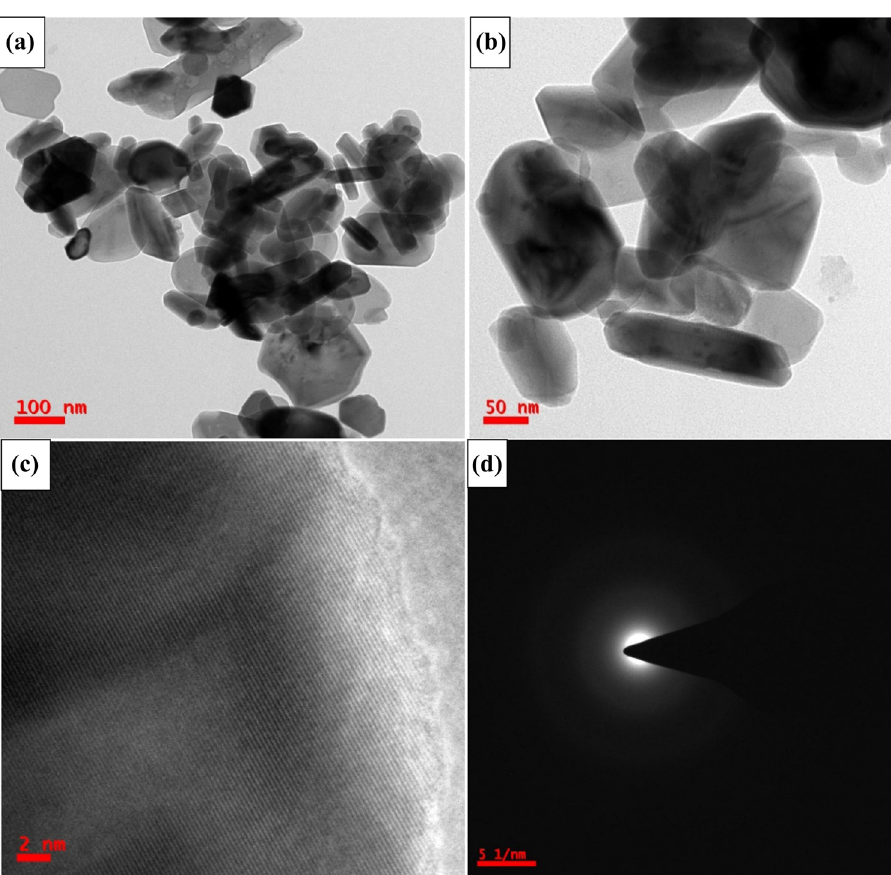
Figure 21: ( a ) and ( b ) TEM images of iron oxide NPs, ( c ) d - spacing, and ( d ) selected area electron di ff raction pattern. Copied with permission from ref. [ 253 ] ; Elsevier,